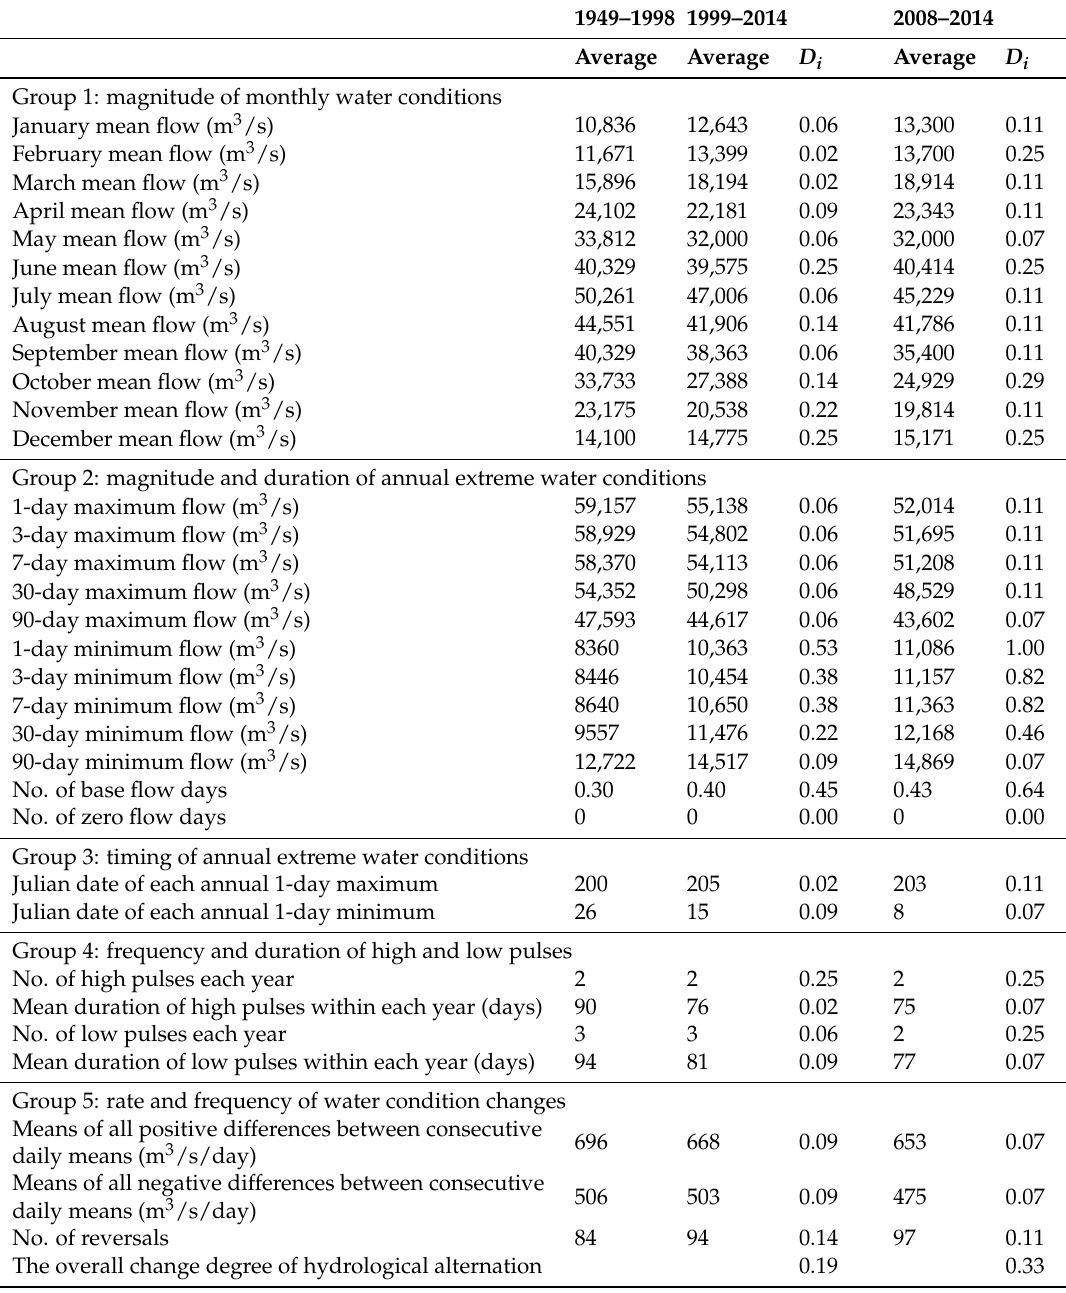
Table 5. Results of IHA indicators change degree under different periods at Datong